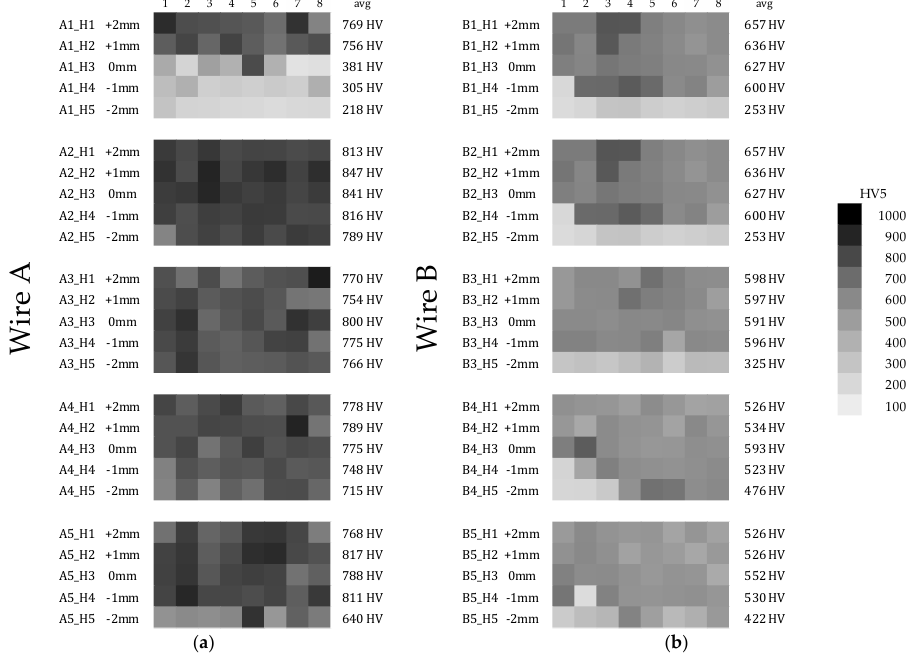
Figure 12. Heatmap of HV5 hardness values for: ( a ) Wire A, ( b ) Wire B. The top row A1 of ( a ) represents incomplete fusion, as there is sharp hardness difference on the base material level. The columns 1 – 8 correspond with the cutting scheme, depicted in Figure 3. The second level A2 of hardness values represent the “sweet - spot”. The ( b ) subfigure shows that Wire B is observably less hard, than Wire A.